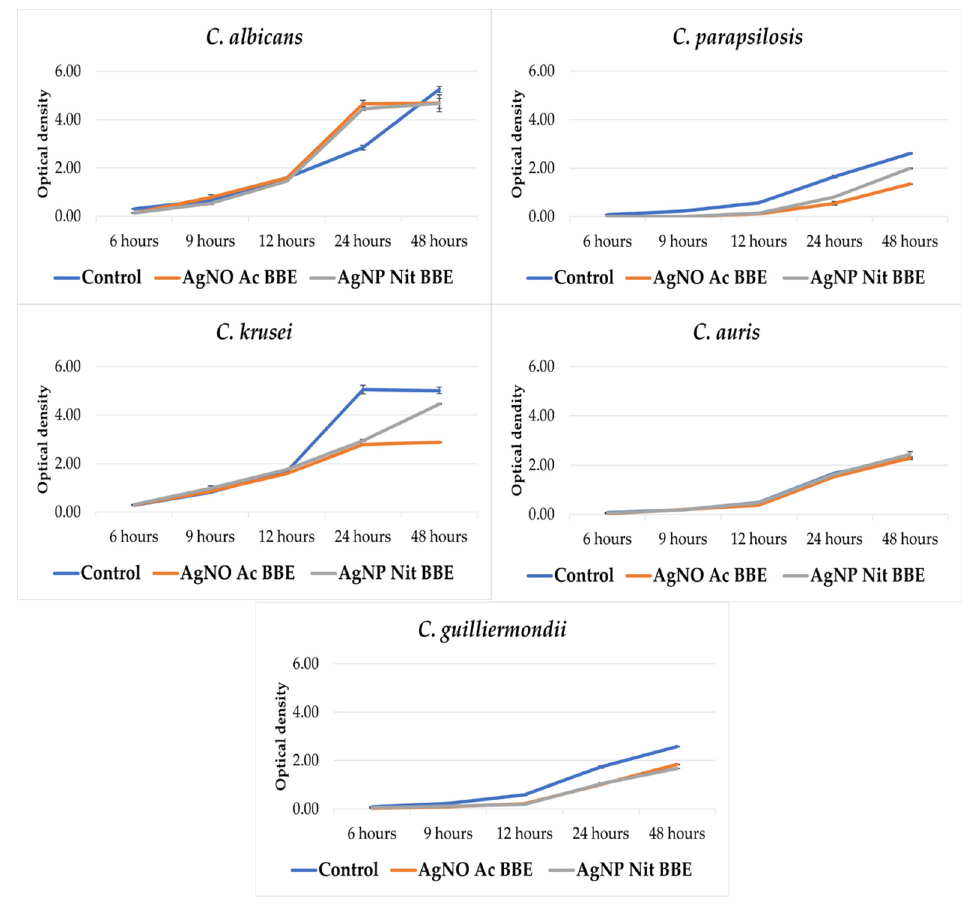
For C . parapsilosis and for C . guilliermondii , both AgNP BBE solutions presented syner- gistic activity with different concentrations of fluconazole (FIC values between 0.16 and 0.5) (Figure 2). In the case of C . parapsilosis , the combination of AgNP Ac BBE with fluconazole presented smaller FIC values (0.16, 0.19) than the combination of AgNP Nit BBE